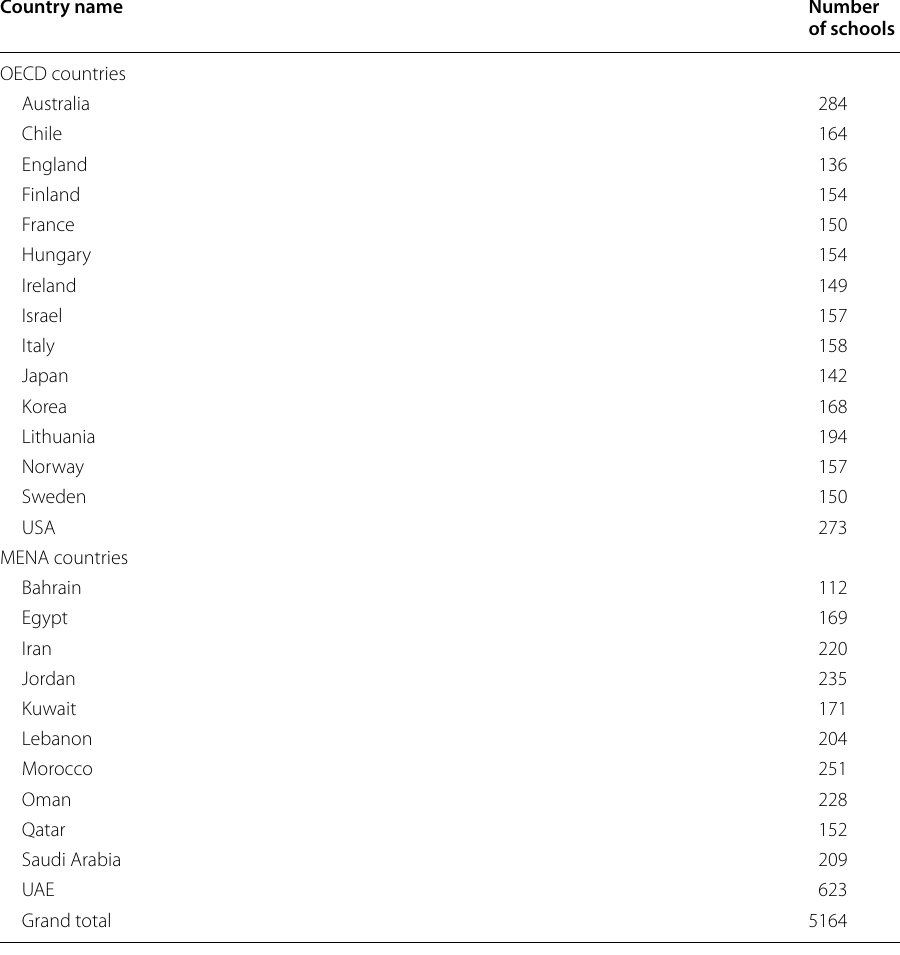
Table 1 Data composition: number of schools across OECD and MENA countries covered in TIMSS